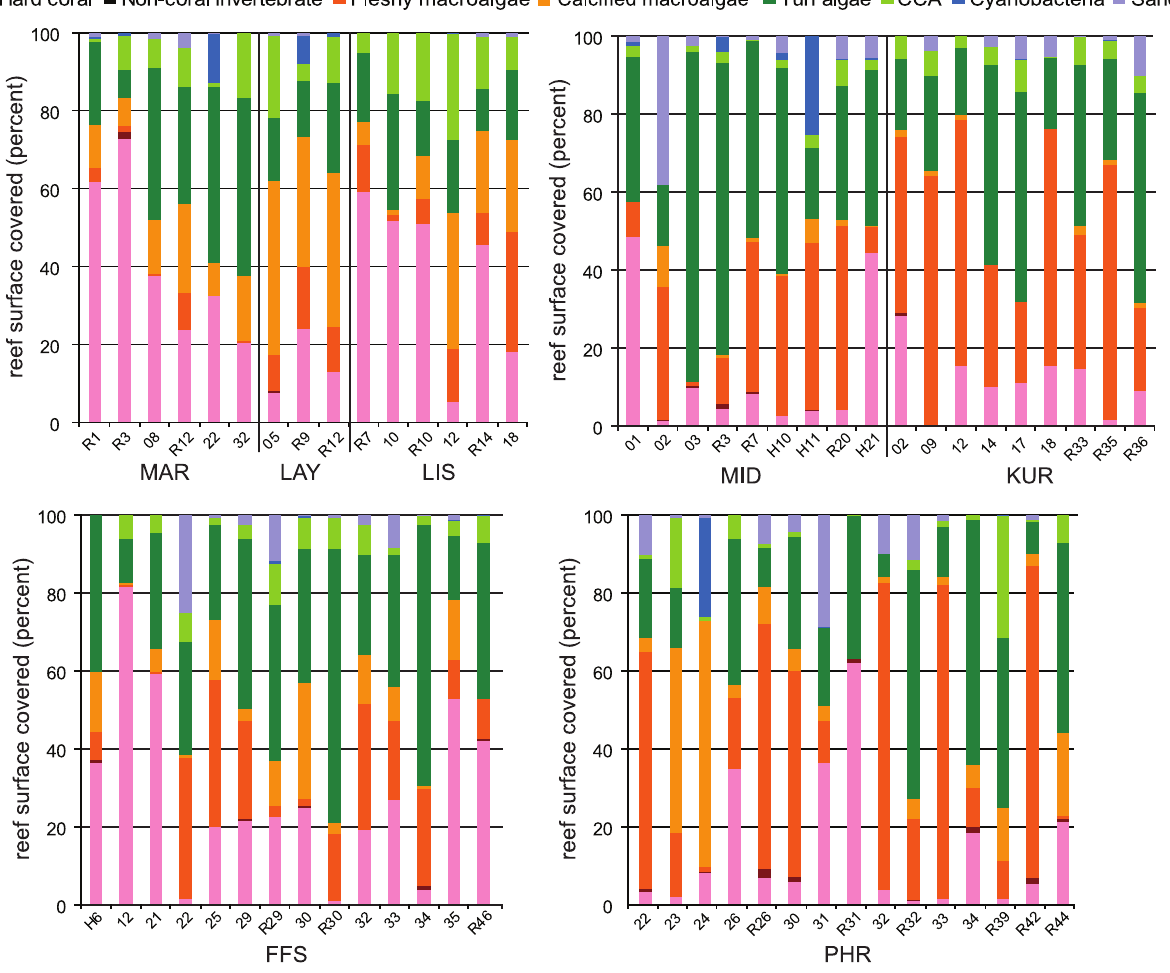
Figure 2. Percent cover of benthic functional groups at surveyed sites in the Papaha¯naumokua¯kea Marine National Monument. Median depth of , 13.7-m. Each site consists of a single replicate, so error bars are not possible. Island abbreviations are the same as in Fig. 1. CCA=crustose coralline red algae.